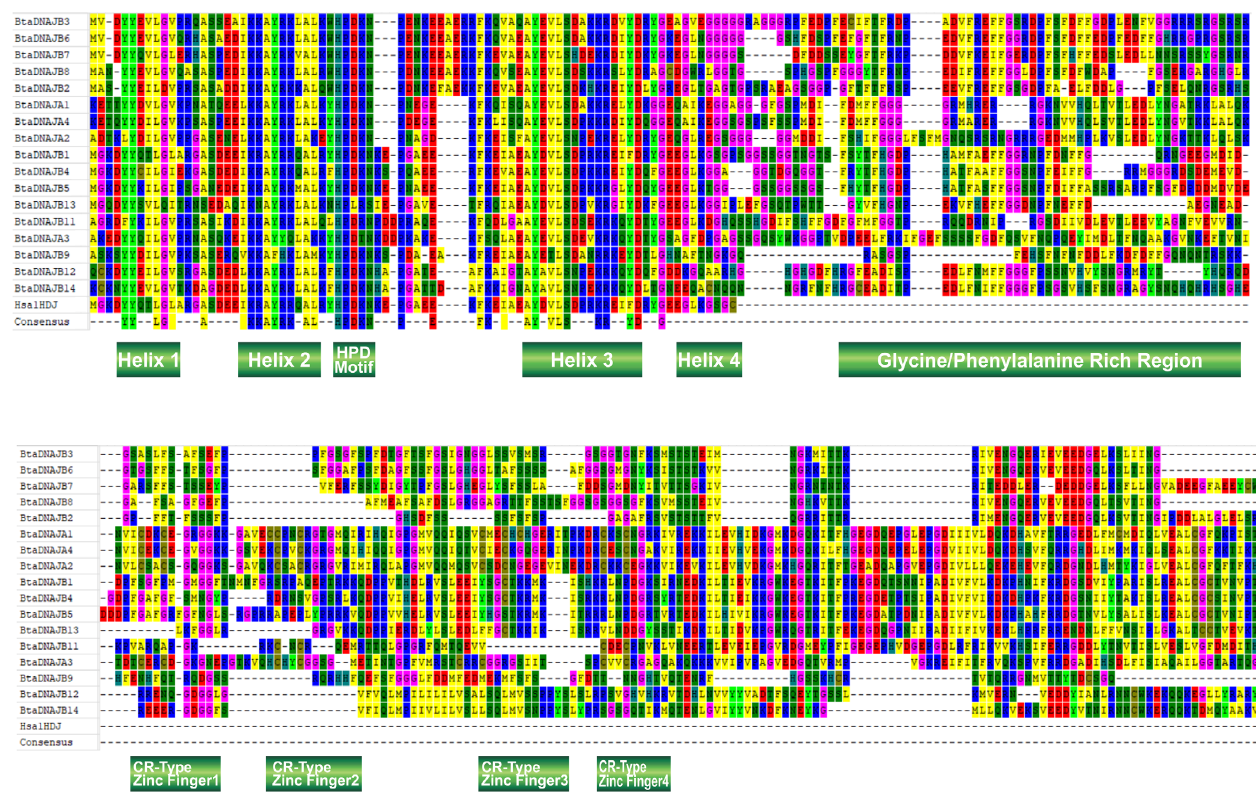
Figure 2. Multiple sequence alignment of cattle Type 1 and 2 heat shock protein 40 domains, including the human 1HDJ domain. The J domain is the most conserved (top region). The 4 conserved CR-type Zinc finger, characterized by the CxxCxGxG motifs, and the glycine/ phenyl alanine region are also shown. The amino acid residues evolutionarily conserved are shown in as the consensus at the bottom. The sites with amino acids having the same biochemical characteristics are shown as colored boxes. Bta represents Bos taurus , and Hsa Homo sapiens.